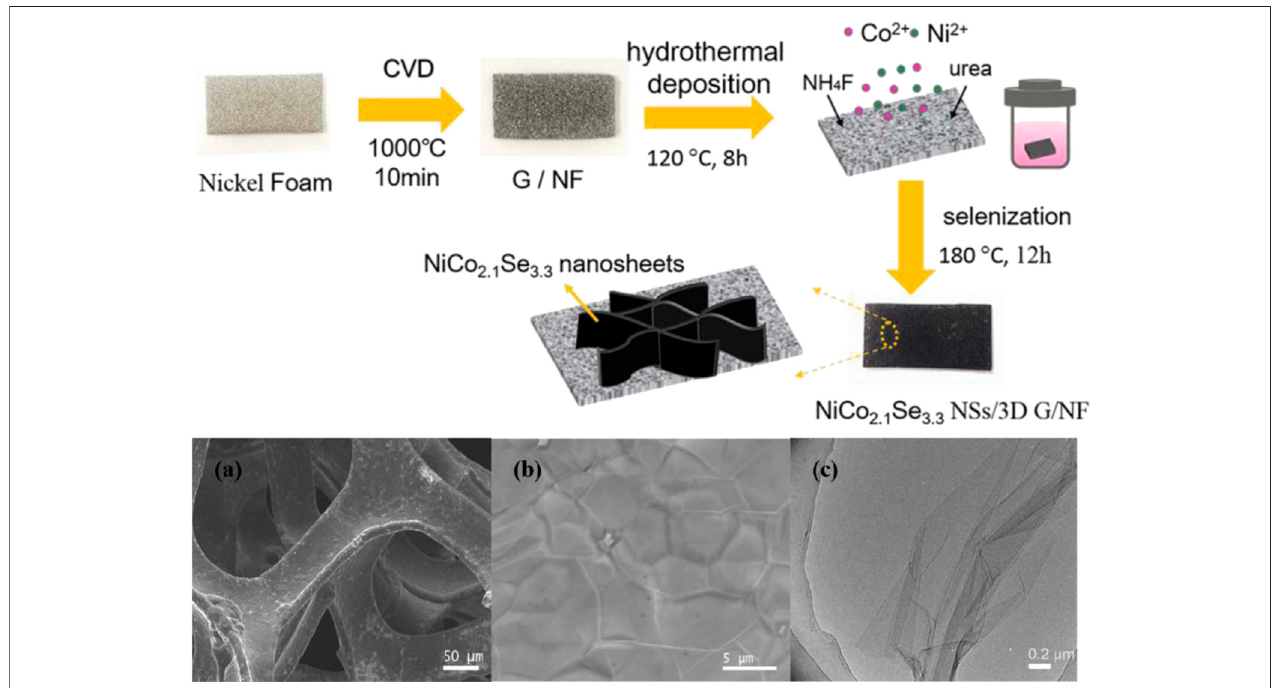
FIGURE 20 | Schematic drawing of the preparation process of NiCo2.1Se3.3 NSs/3D G/NF binder-free electrode.